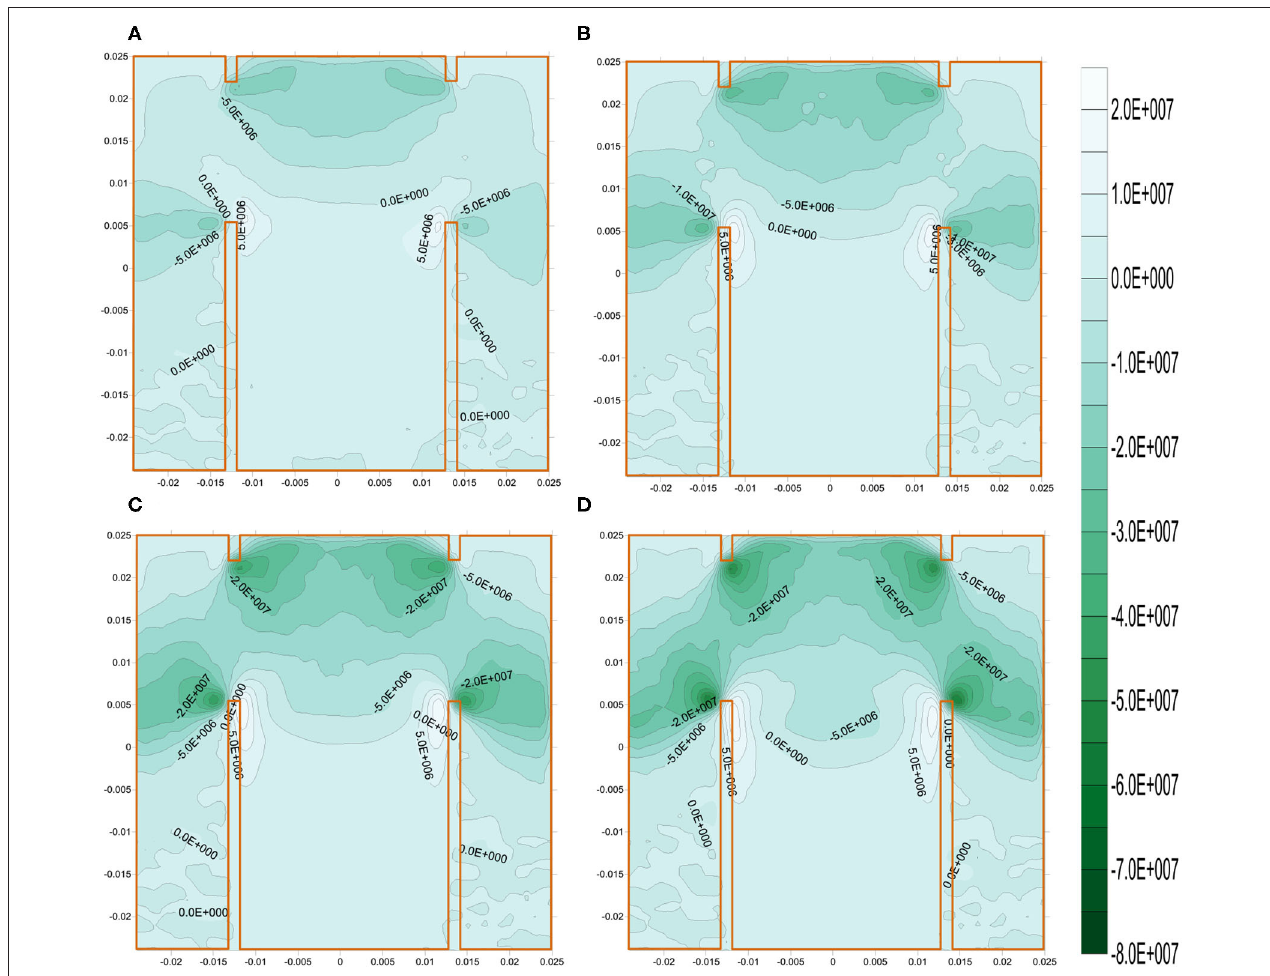
FIGURE 10 | The maximum principal stresses before tensile crack initiations: (A–D) are for the confining stresses of 0, 5, 10, and 15 MPa, respectively.